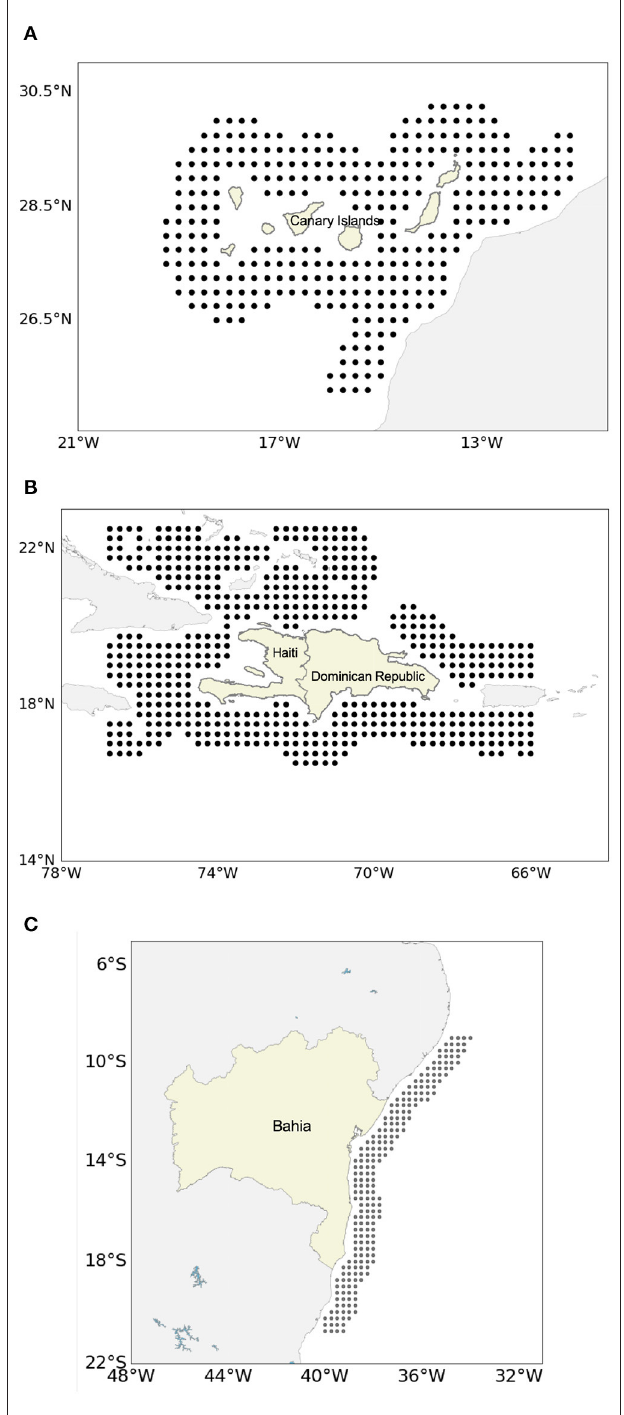
FIGURE 1 | Map of release points (black dots) for the (A) Eastern Atlantic Archipelago, (B) the Western Atlantic Island, and (C) coastline of Bahia (Brazil).